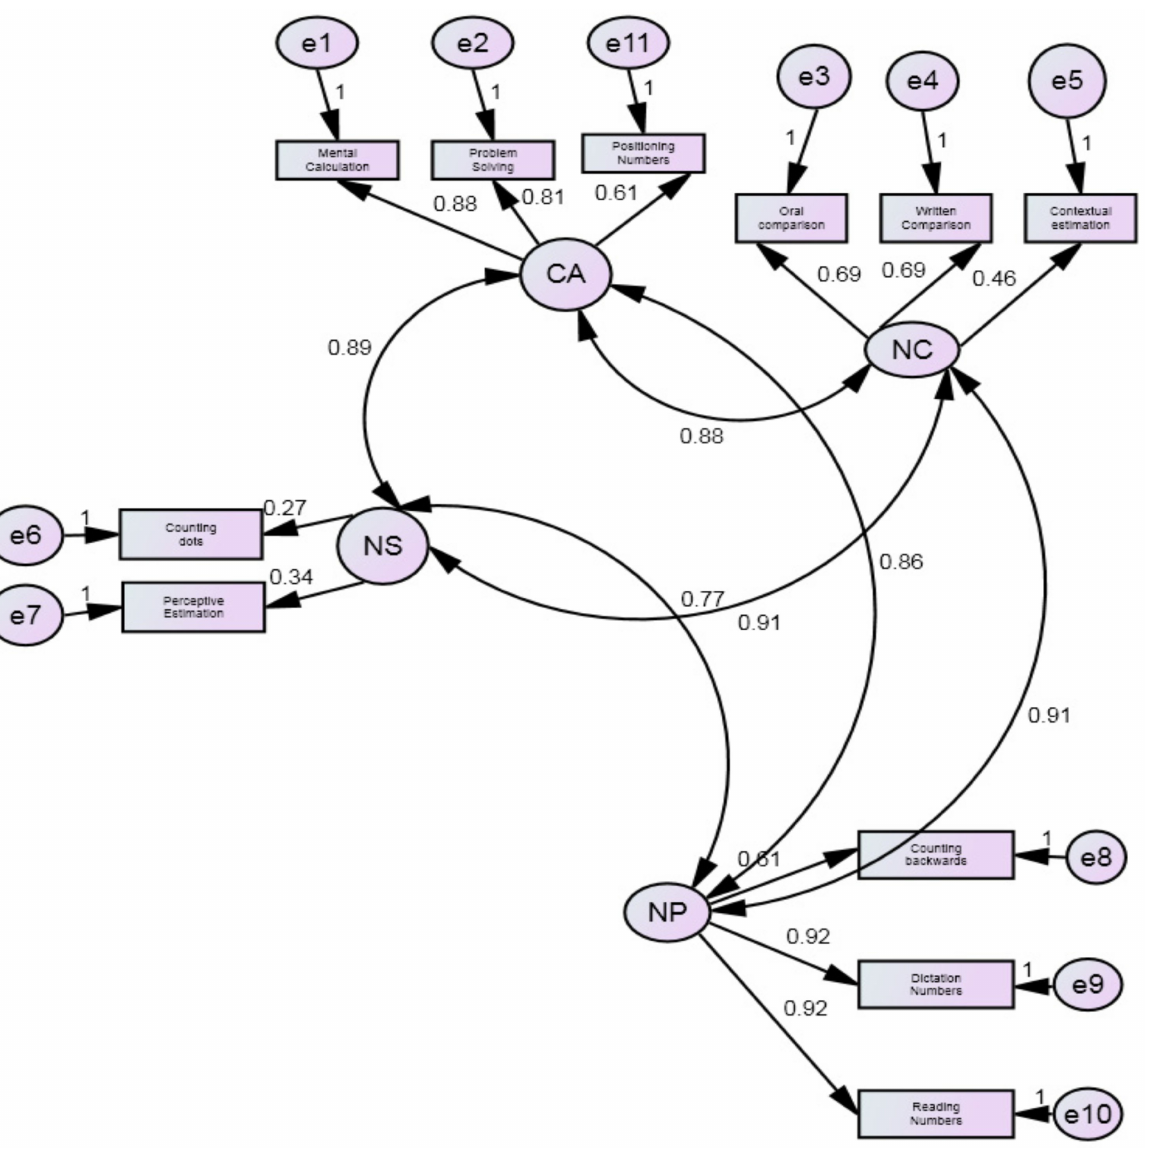
Figure 2. The four factors structure: CA= Calculation, NS= Number Sense, NC= Number Calculation, NP= Number